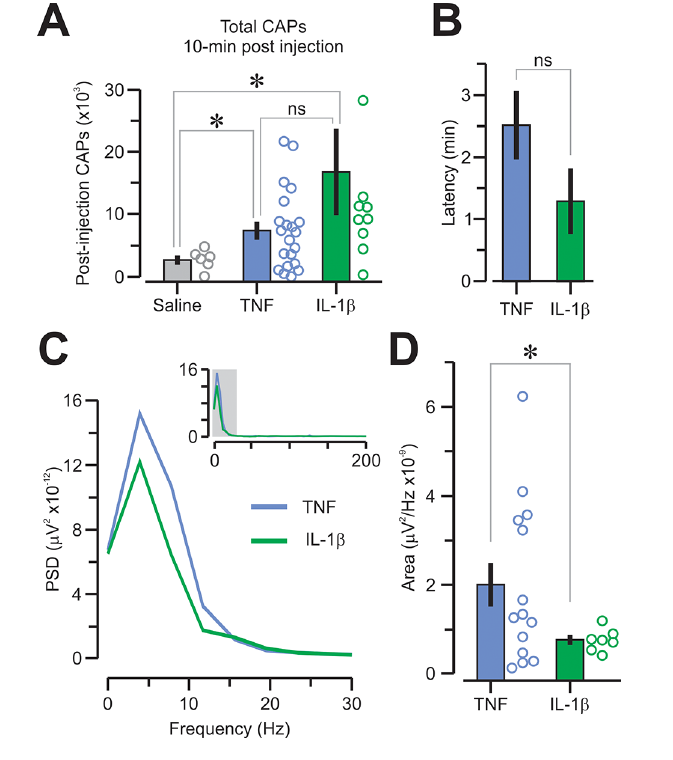
Figure 6. Time domain and spectral analysis of TNF- and IL-1 β –mediated neurograms. (A) Plot showing the total CAP counts in the 10-min period immediately after cytokine administration (saline, 200 μ L per mouse, N = 6; TNF, 50 μ g per mouse, N = 21; IL-1 β , 350 ng/kg, N = 10). Values between the saline control and each cytokine are statis- tically significant (*, P < .05, MW test), but the cytokines are not significantly different from each other (ns, P = .07, t test). (B) Graph depicting the latency (mean ± SEM) for the TNF and IL-1 β responses, with no significant difference between values ( P = .16, t test). (C) Power spectral densities (PSDs) for the TNF (blue) and IL-1 β (green) responses in the 0–30 Hz range for the unfiltered neurogram recordings. (Inset) PSD for the 0–200 Hz range, with the gray rectangle indicating the expanded plot. (D) The areas under the